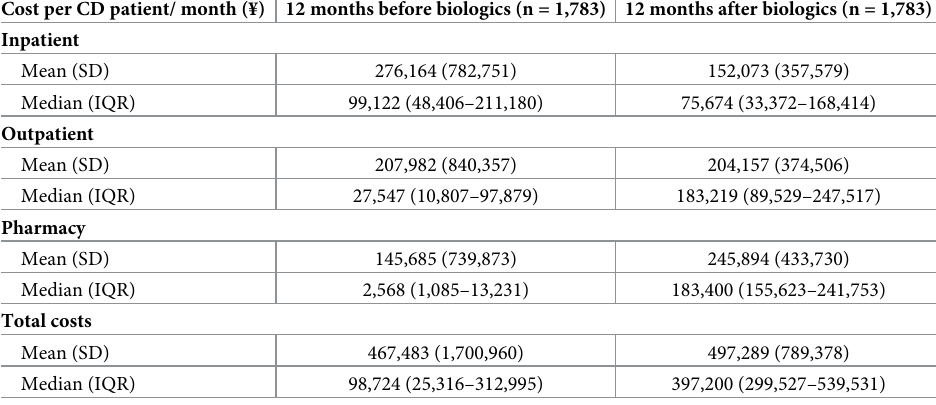
Table 4. Direct costs 12 months before and after biologic initiation.